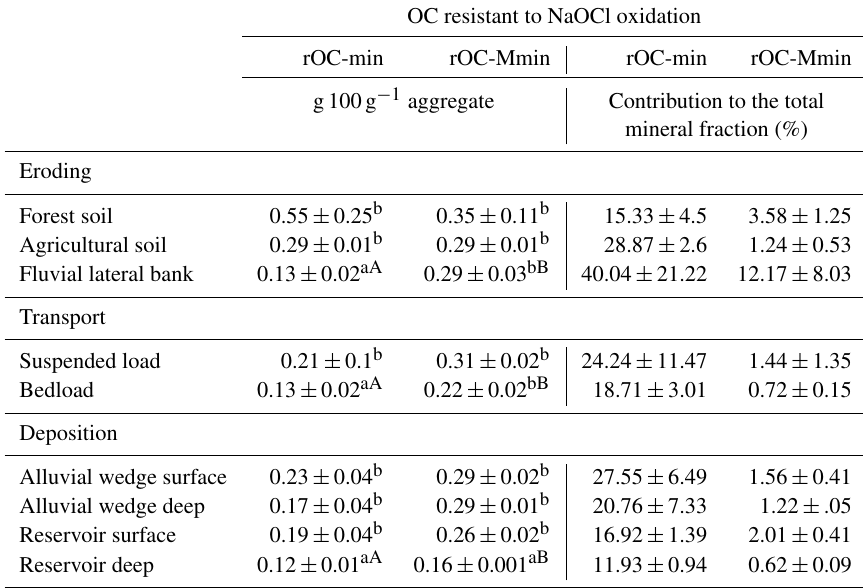
Table 3. OC resistant to NaOCl oxidation in the free mineral fraction (rOC-min) and occluded mineral fraction (rOC-Mmin); contribution of rOC-min and rOC-Mmin to the total mineral fraction in the different morphological positions across the catchment: eroding, transport, and depositional areas.